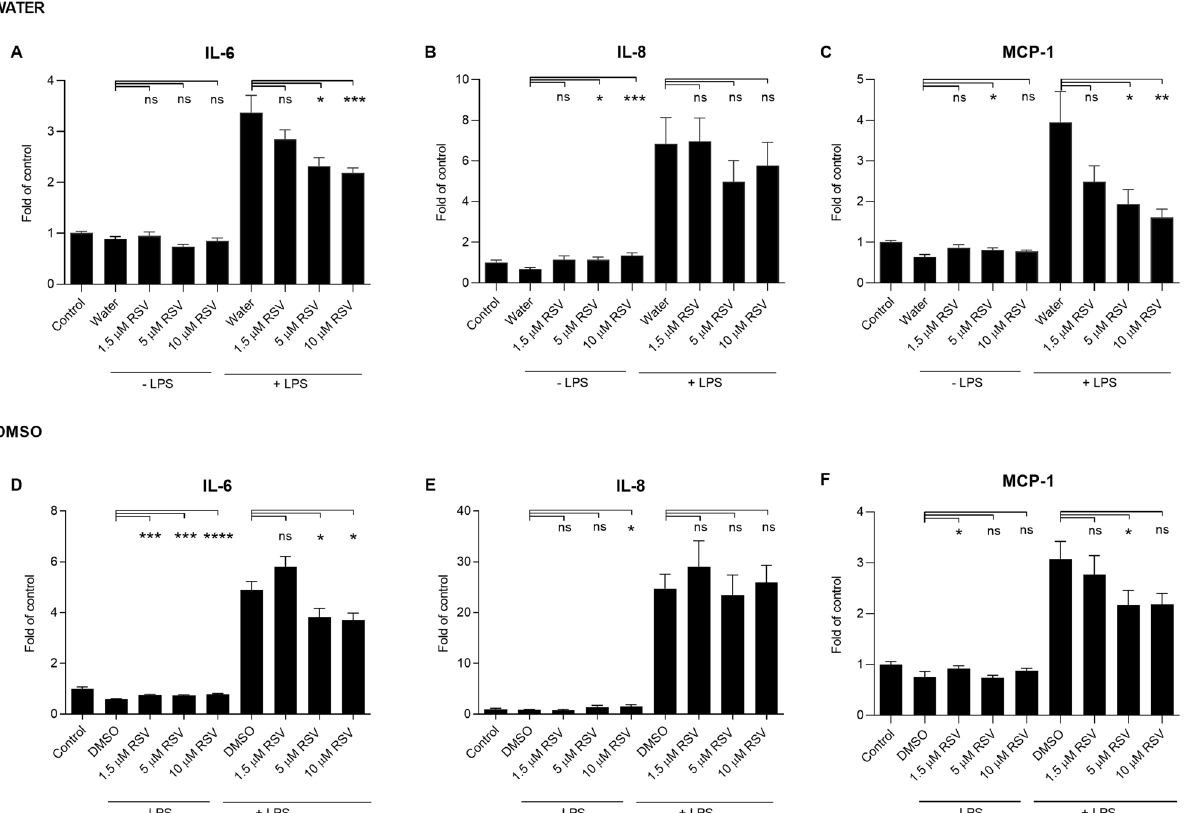
Figure 3. The effect of rosuvastatin (RSV) on the production of pro-inflammatory cytokines in human RPE cells at 24 h incubation. The levels of IL-6, IL-8, and MCP-1 were measured following the exposure of RSV dissolved in water ( A – C ) or DMSO ( D – F ) with or without additional exposure to LPS for 24 h. The results are represented as fold of control, which was set to be 1. Results are combined from 3 independent experiments with 4 parallel samples per group in each experiment ( A – C , F ) and from 4 independent experiments with 4 parallel samples per group in each experiment ( D – E ) and shown as mean ± SEM. *P < 0.05, **P < 0.01, ***P < 0.001, ****P < 0.0001, ns not significant, Mann–Whitney U